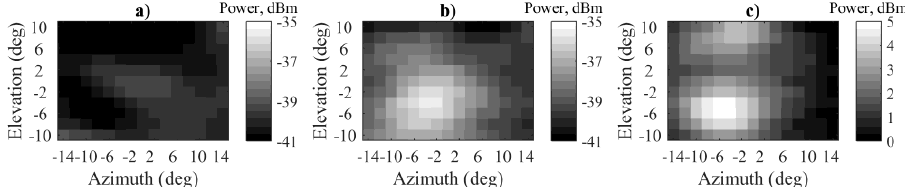
Fig. 7. Cube with a rough surface: a) background image from radiolight lamps; b) cube is located in front of the antenna at a distance of 2 m; c) differential image.